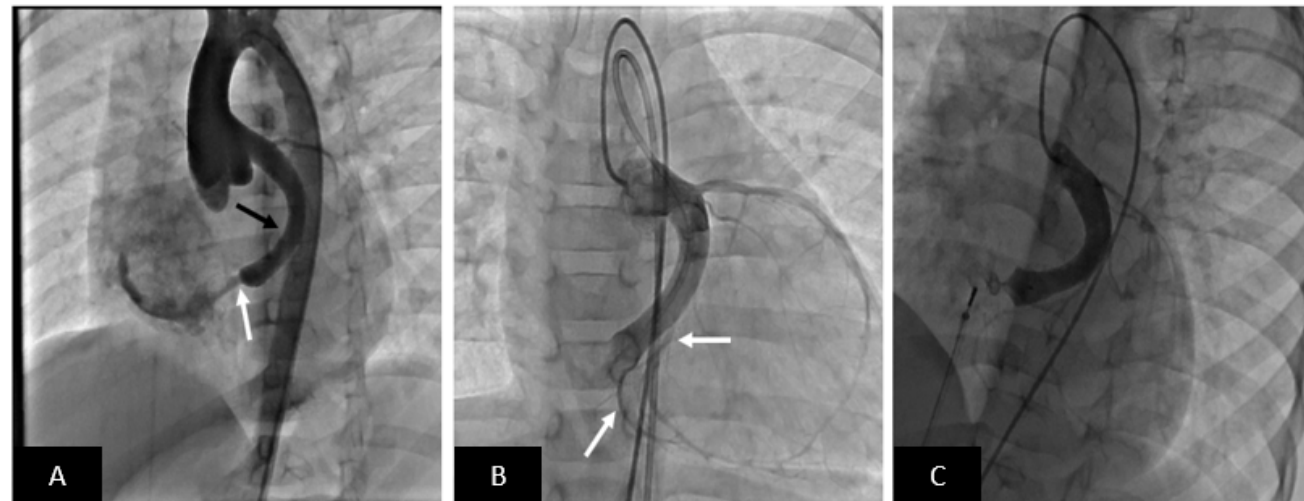
Figure 12. Transcatheter closure of large coronary artery fistula to the right atrium with Amplatzer Duct Occluder II (ADO-II). ( A ) Aortogram in cranially angulated left anterior oblique projection shows a coronary fistula from the left circumflex coronary artery into the right atrium (white arrow). The circumflex artery is dilated (black arrow). Note no coronary artery branches off the circumflex are visible. ( B ) Balloon occlusion coronary angiogram shows important coronary artery branches including a few just proximal to where the fistula enters the right atrium. This is of critical importance to avoid inadvertent occlusion of the branches by the occluding device. ( C ) The fistula is successfully occluded with an ADO-II (off-label use) device and no residual flow is seen. Note preserved flow into the terminal coronary artery branches.